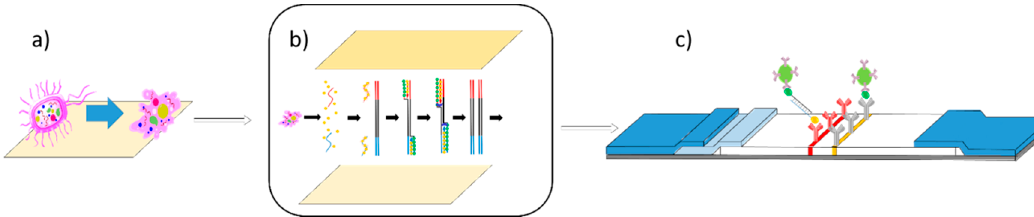
Figure 1. Lab-on-a-chip for solid phase-based lateral flow assay. ( a ) An illustration of solid phase lysis taking place on cellulose paper. ( b ) Illustration of solid phase lysis paper being pressed against solid phase RPA paper, allowing for RPA reactions to then take place. ( c ) Illustration of nucleic acid lateral flow detection of products of solid phase RPA. (Adapted from Piepenburg et al. [32].)